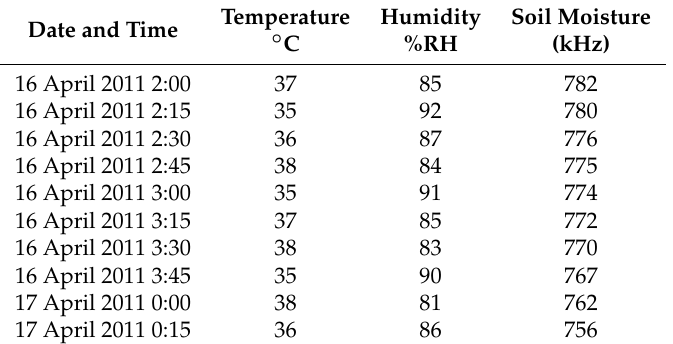
Table 2. A short description of the collected time series data “T” for a single sensor node—measured at 15 min intervals (soil moisture represents soil wetness kilo